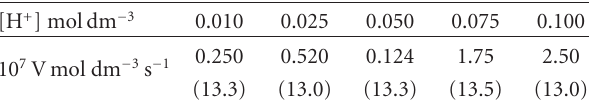
Table 3: E ff ect of variation of [H + ]. 10 3 [NBS] = 5.00 moldm −